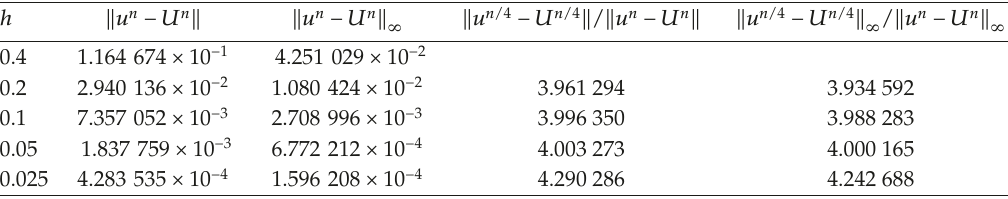
Table 2: The errors of numerical solutions at t (cid:7) 60 with τ (cid:7) h for p (cid:7)